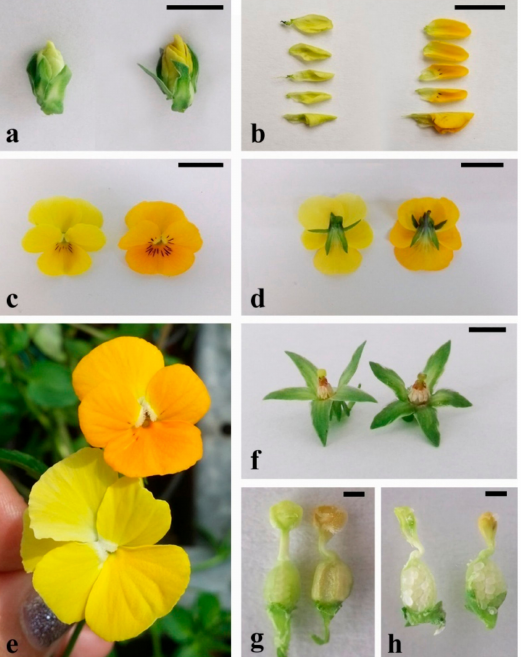
Figure 7. Flower color change of greenhouse-grown V. cornuta untransformed (left) and Llccs + transgenic plants (right). ( a ) Flower buds; ( b ) Isolated petals of flower buds; ( c ) Fully open flowers; ( d ) Back side of the flowers; ( e ) Flowers of control and Llccs + plants in a greenhouse; ( f ) Flowers free of petals; ( g ) Pistils; ( h ) Longitudinal section through the pistils. Bars: ( a , e , f )—10 mm; ( b – d )—20 mm; ( g , h )—3